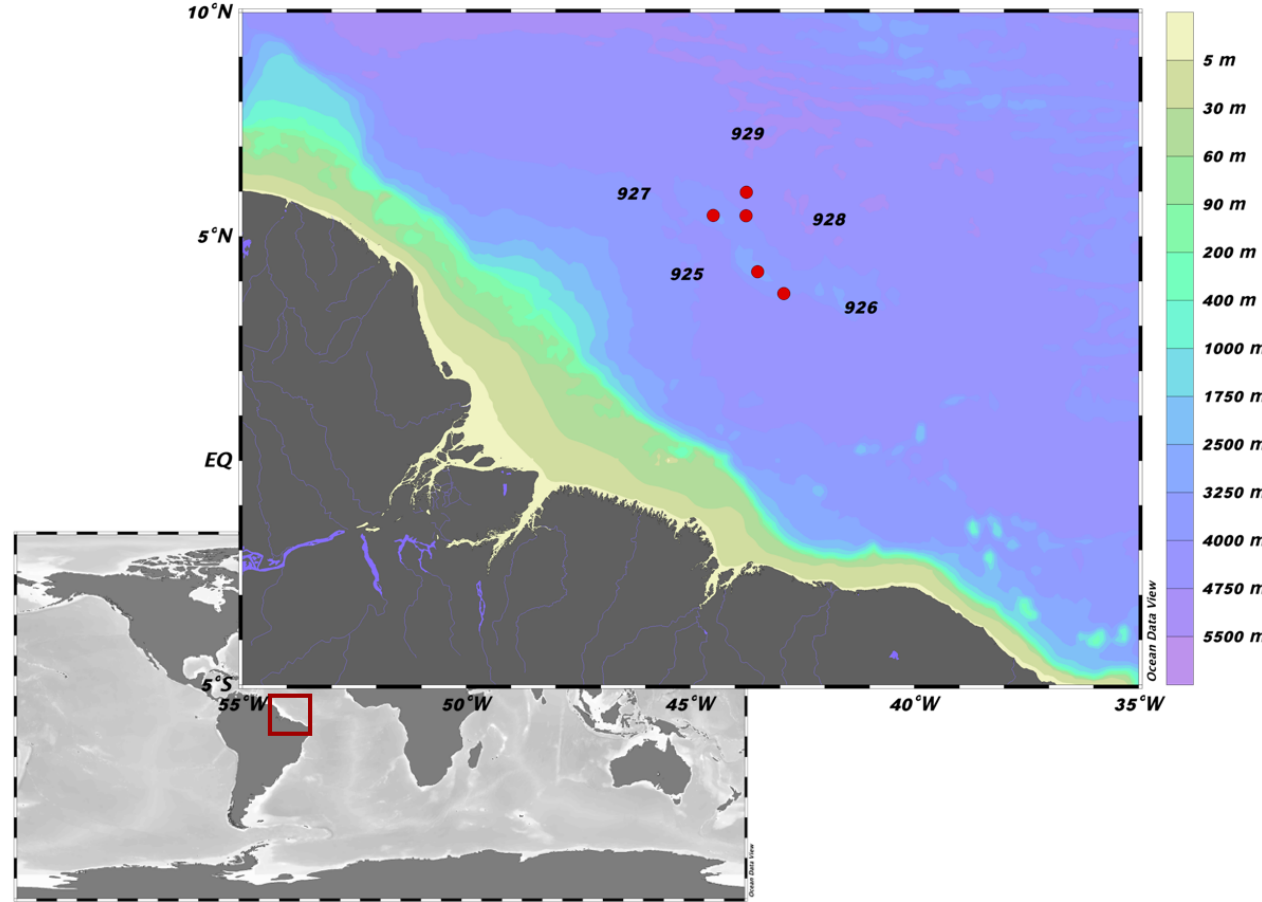
Figure 1. Location of the material of this study at the Ceara Rise, ODP Leg 154 (Ocean Data View, Schlitzer,